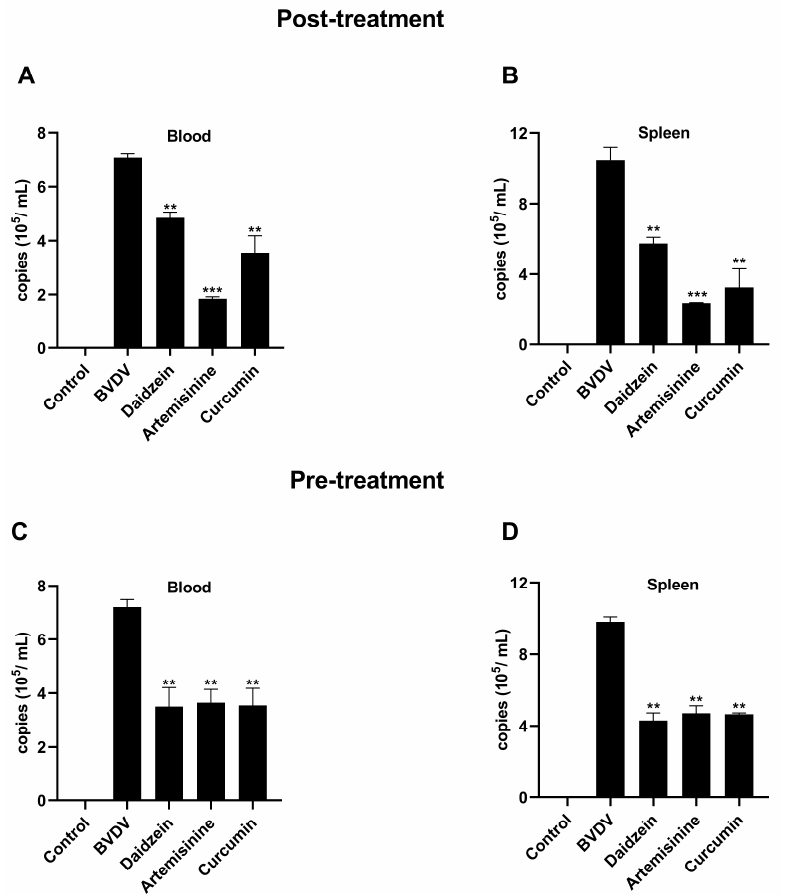
Figure 7. Results of anti-BVDV viral effects of Chinese herbal monomers in mice in vivo. Post- treatment ( A ): Inhibitory effect of Chinese herbal monomers on viruses in blood in vivo. ( B ): In- hibitory effect of Chinese herbal monomers on viruses in splenic in vivo. Pre-treatment ( C ): Effect of Chinese herbal monomers pre-treatment on the viral content of blood in vivo. ( D ): Effect of Chinese herbal monomers pre-treatment on the viral content of splenic in vivo. *** p < 0.001, ** p < 0.01, n = 3. Data were presented as mean ±